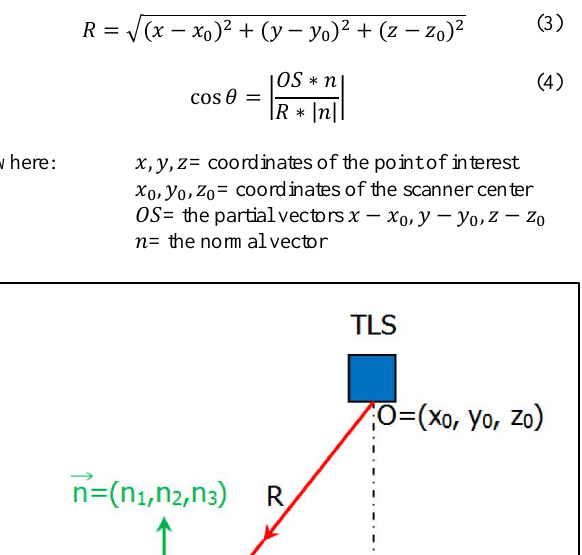
Figure 3. Sample of selection of reference points.